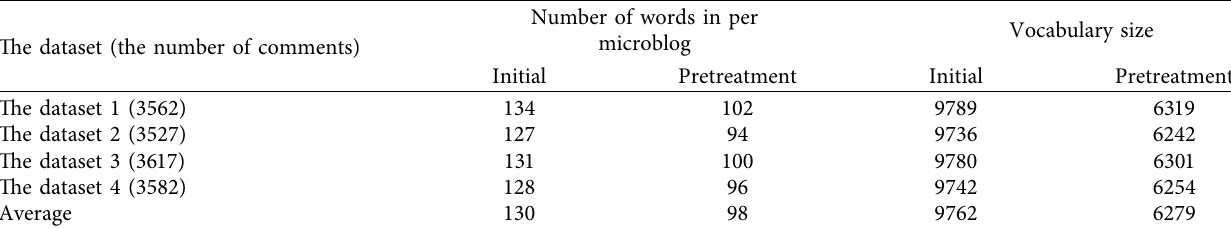
Table 2: Experiment datasets.